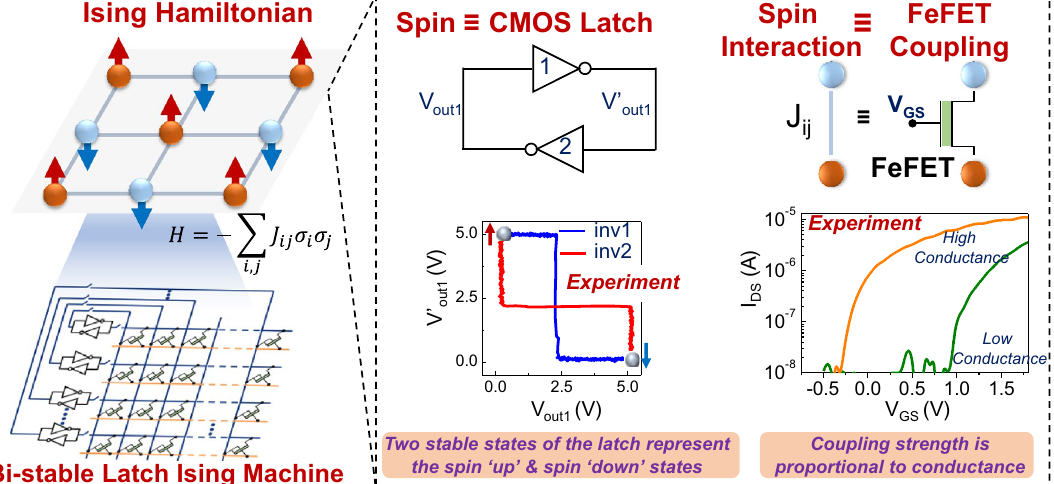
Figure 1. Overview of bi-stable latch based ising machine hardware. Proposed design for the Ising machine using CMOS latches (cross-coupled inverters) as artificial Ising spins. The interaction among the spins is implemented using a CMOS-process compatible FeFET based